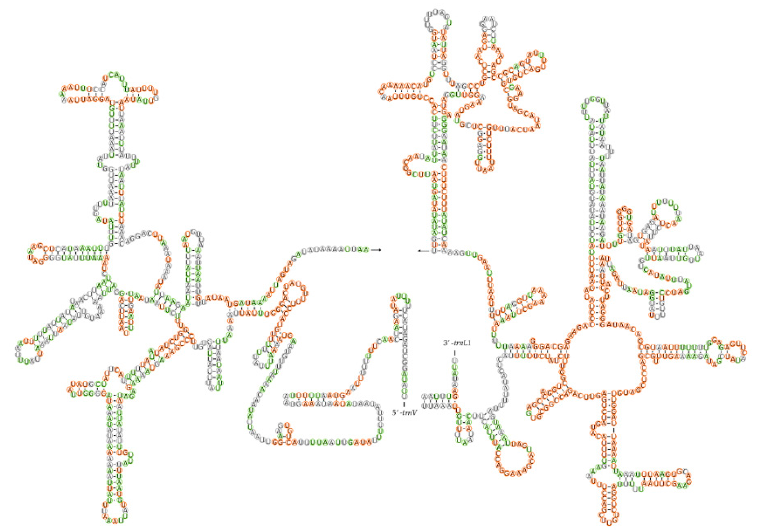
Figure 5. Potential secondary structure of 16S rRNA in Eysarcoris rosaceus . The sites conserved within Eysarcoris are labeled in green, and those of Pentatominae are marked in orange.